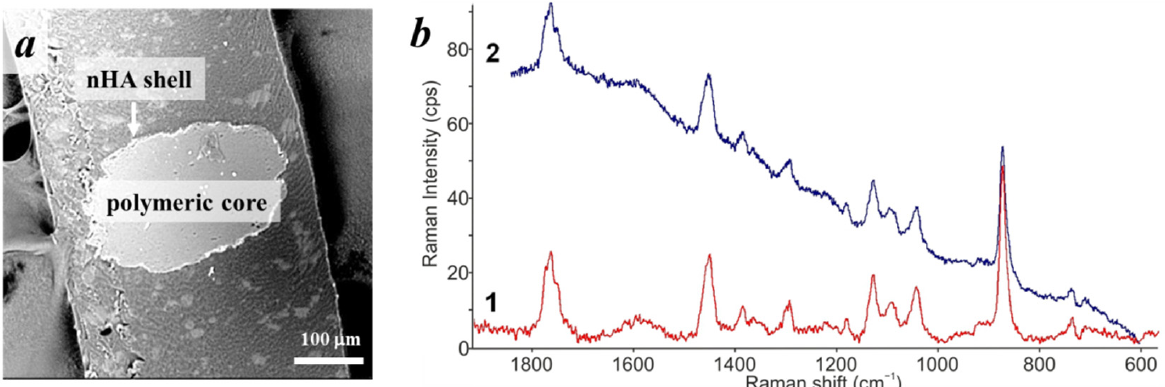
Figure 7. ( a ) SEM image of the cross-section of the PLA-based microparticle stabilized with 1 wt% of nHA without preliminary US treatment of aqueous phase; ( b ) Raman spectra of PLA (1) and from a cross-section of the PLA-based microparticle (2).